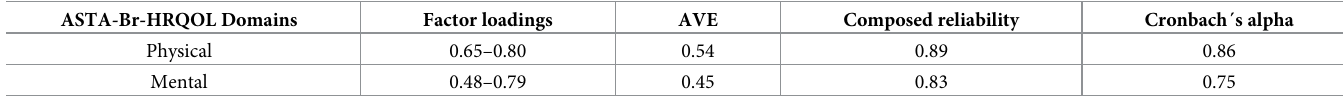
ASTA-Br HRQOL = the Arrhythmia-Specific Questionnaire in Tachycardia and Arrhythmia—Brazilian version- health-related quality of life scale. AVE: Average Variance